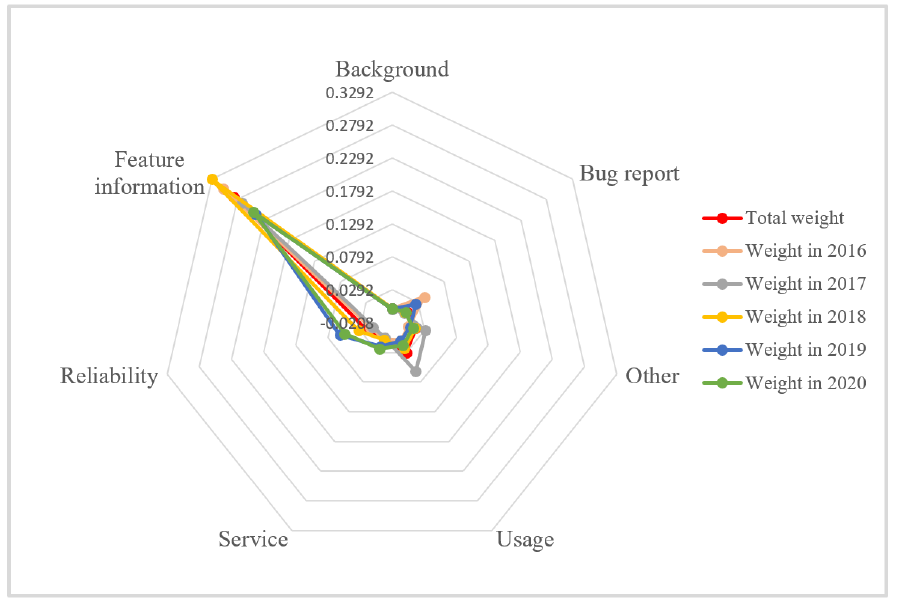
Figure 2. 2016–2020 Ping An Health App Weight Radar